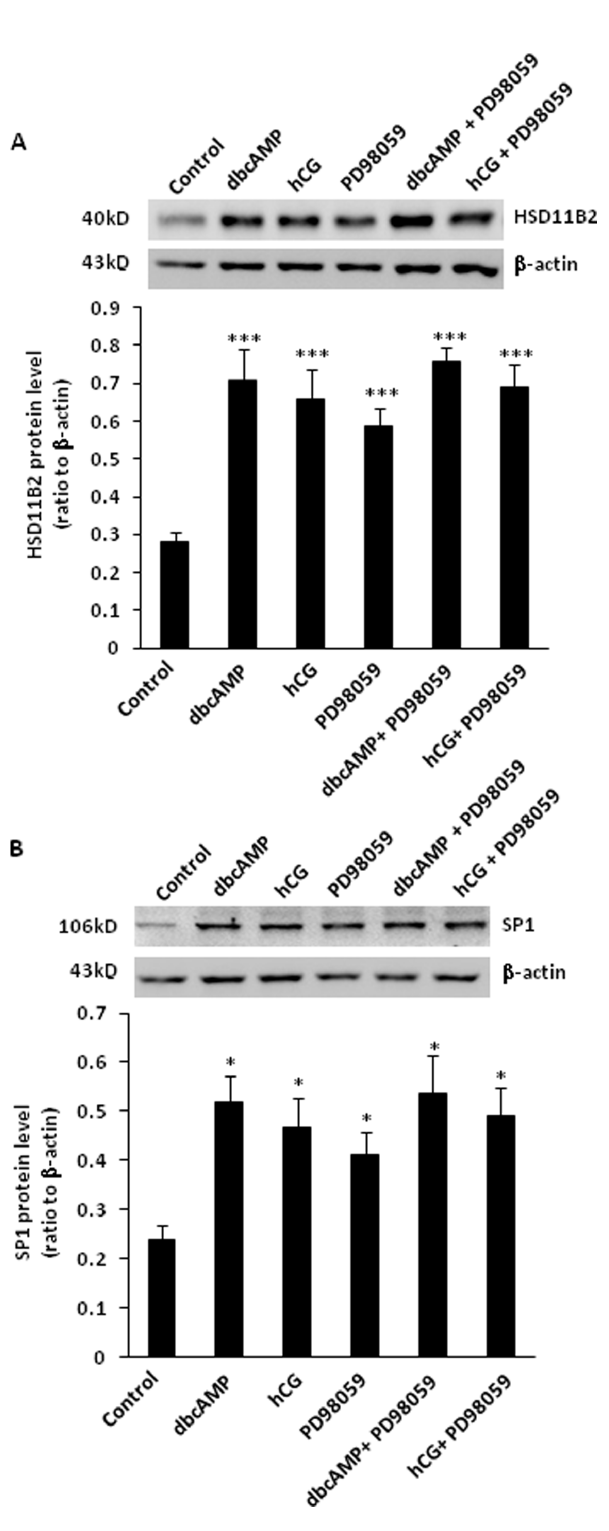
Figure 5. (A) Effect of SB203580 (p38 MAPK inhibitor, 10 m M) on the basal and dbcAMP (100 m M) and hCG (10 IU/ml)- induced HSD11B2 protein level in human placental syncytio- trophoblasts. *p , 0.05 versus control(n=4). (B) Effect of SB203580 (p38 MAPK inhibitor, 10 m M) on the basal and dbcAMP (100 m M) and hCG (10 IU/ml)-induced SP1 protein level in human placental syncytio- trophoblasts. ***p , 0.001 versus control (n=4).